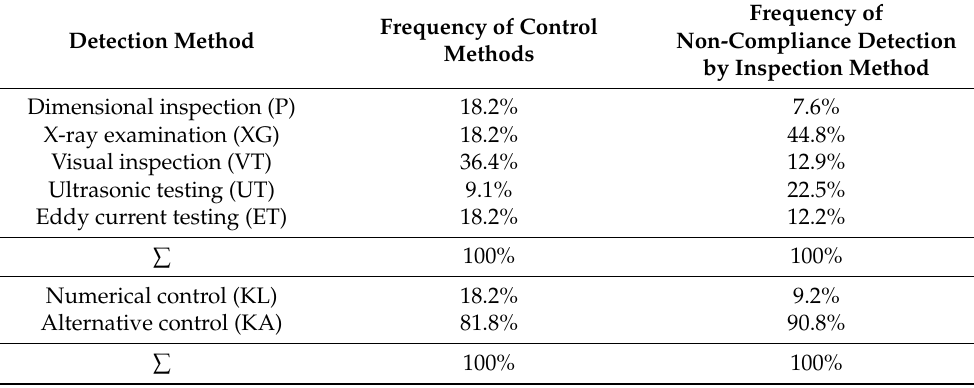
Table 2 also includes: KL—numerical inspection and KA—alternative inspection. Table 2. Types and number of non-conformities of the adaptor flange casting during the period